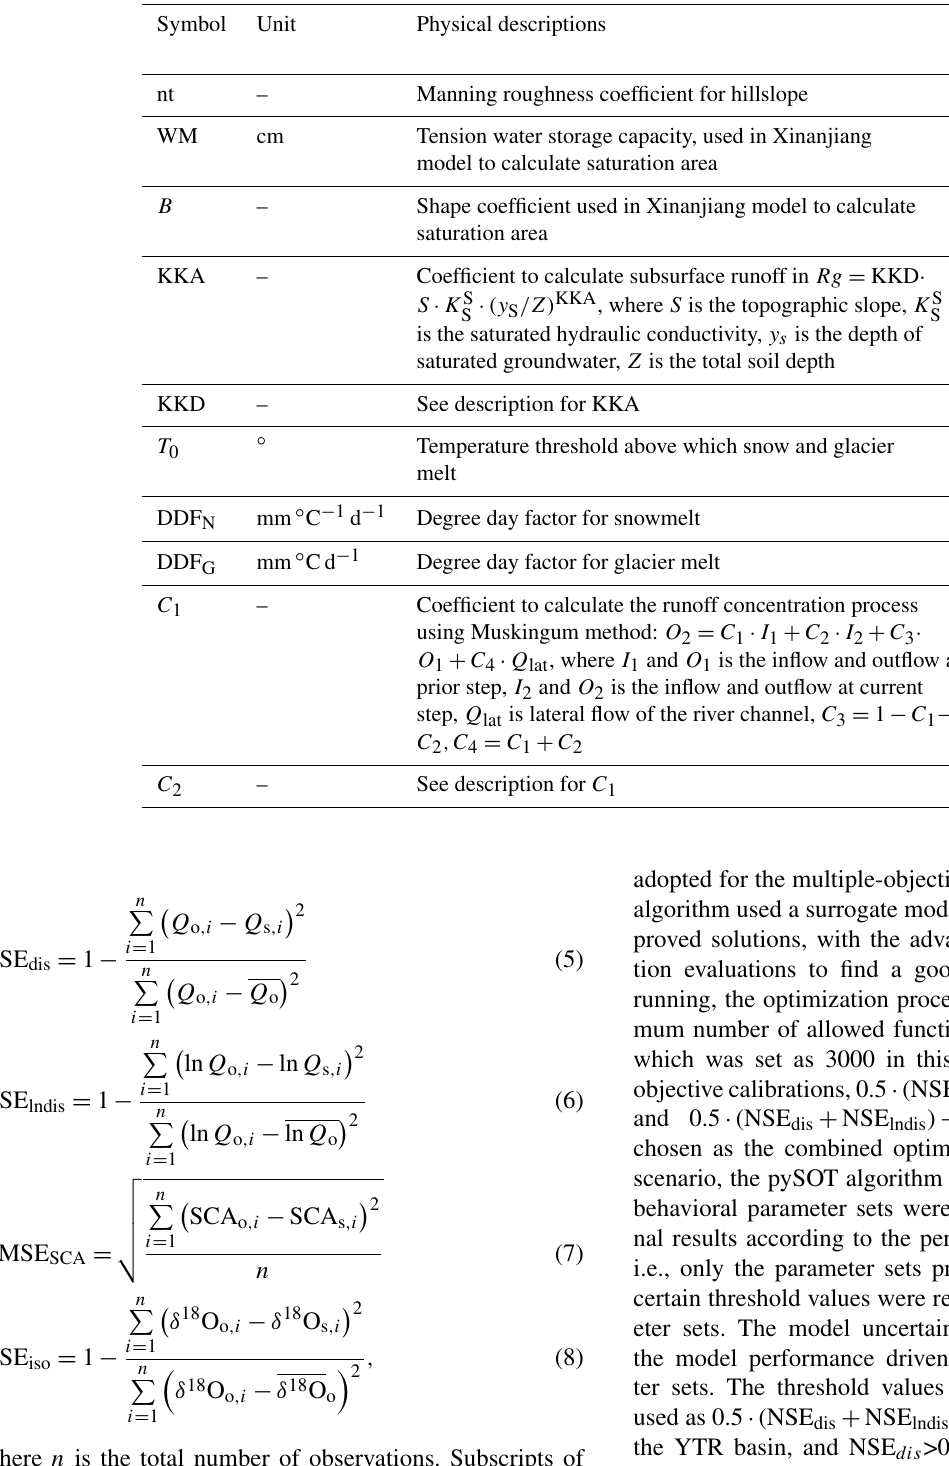
Table 2. Calibrated parameters of the THREW-T